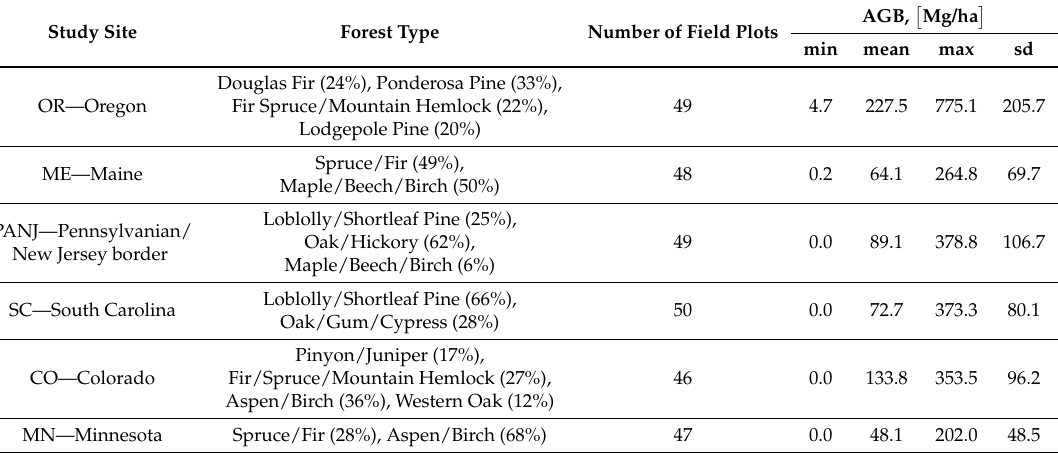
Table 1. Overview of field data.